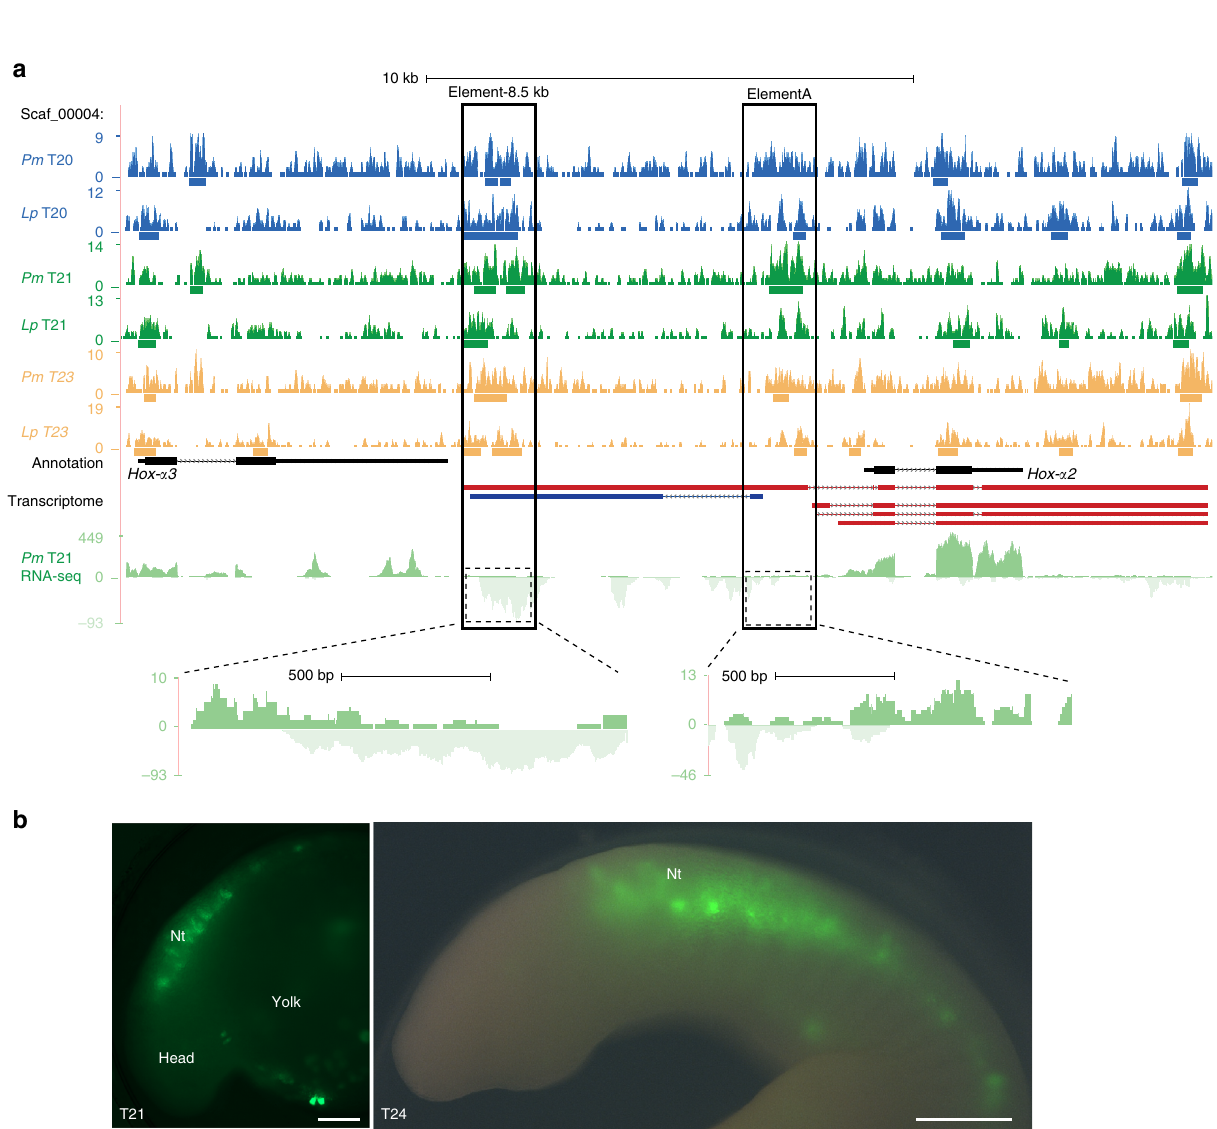
Fig. 4 Characterisation of a Hox- α 2 enhancer and associated transcription. a The Hox- α 3 / Hox- α 2 locus in the sea lamprey germline genome, with merged replicate ATAC-seq coverage tracks from the sea lamprey ( Pm ) and brook lamprey ( Lp ) at each developmental stage, as well as RNA-seq coverage tracks from a representative T21 sample indicating directional transcription. Bars below ATAC-seq coverage plots indicate peak regions identi fi ed with Macs2. The black boxes highlight two ATAC-seq positive regions within the 9-kb region upstream of the Hox- α 2 locus and the dashed boxes highlight bidirectional transcription over these regions. De novo assembled transcripts for the Hox- α 2 locus are shown maroon (sense) and dark blue (antisense). b GFP reporter expression in lamprey embryos injected with the element-8.5 kb enhancer-reporter construct at one-cell stage and allowed to grow to indicated stages (observed in 10 out of 149 injected embryos). GFP reporter expression is seen in the neural tube. Scale bars: 200 μ